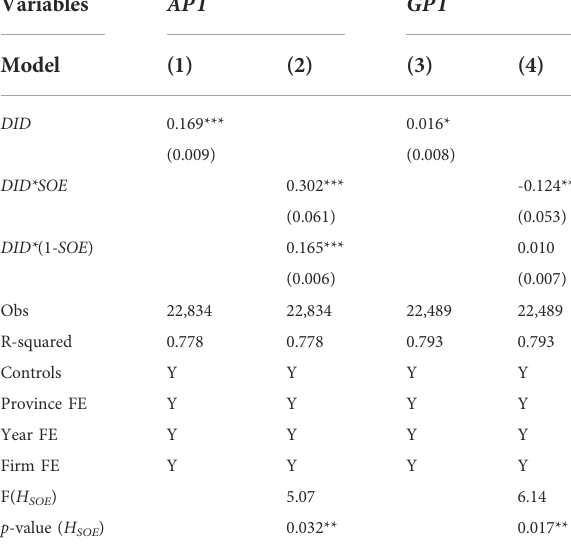
TABLE 14 Innovation mechanism estimation results. Variables